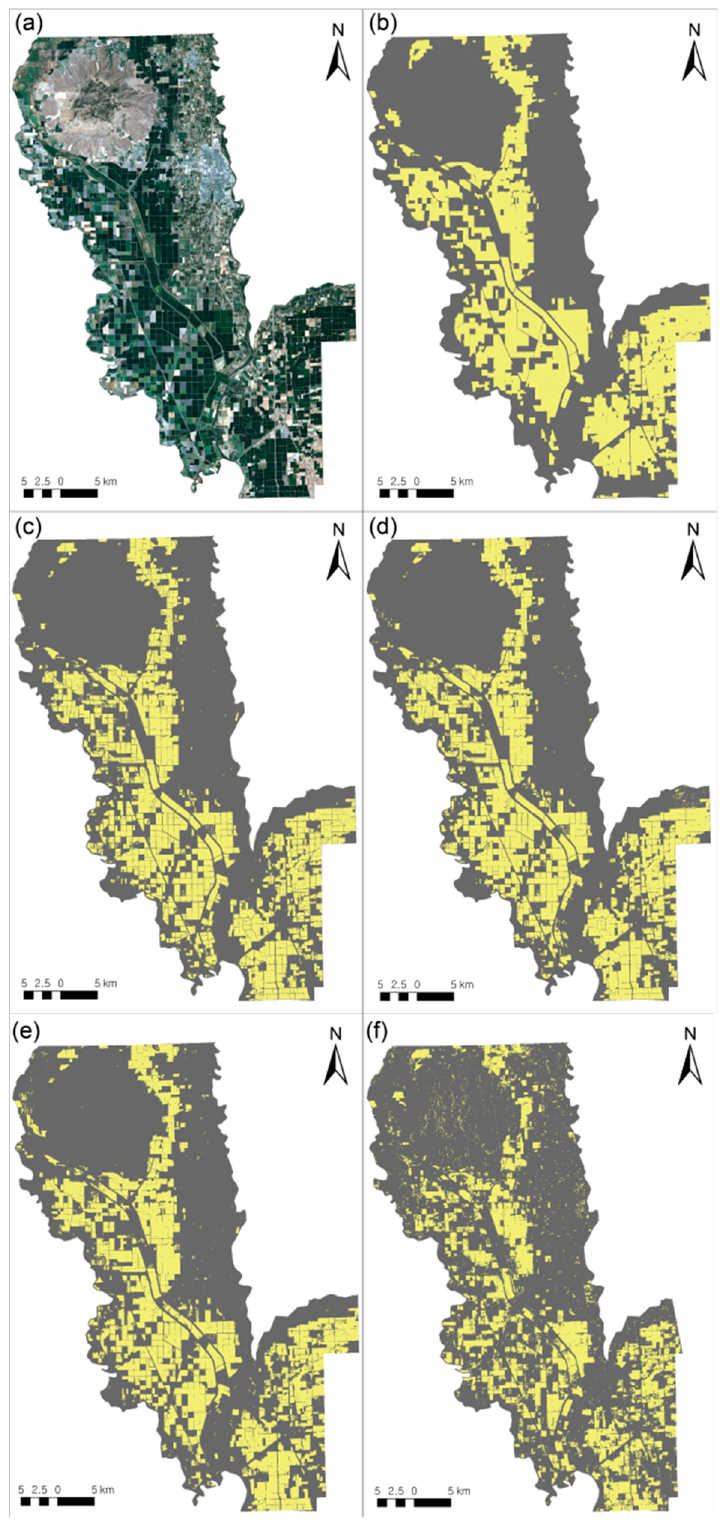
Figure 7. Spatial distribution of paddy rice maps at site A. ( a ) Landsat 5 RGB image on 26 July 2009; ( b ) reference map; ( c ) Random forest (scheme 6)-derived map; ( d ) Support Vector Machine (SVM) (scheme 6)-derived map; ( e ) PMI (NIR)-derived map; and, ( f ) PMI (Synthetic Aperture Radar (SAR))-derived map. Paddy rice fields are shown in yellow.